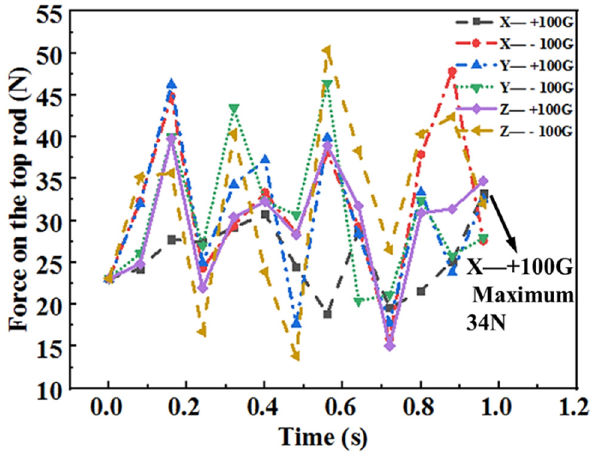
Figure 12. Force diagram of the top rod under different acceleration conditions.